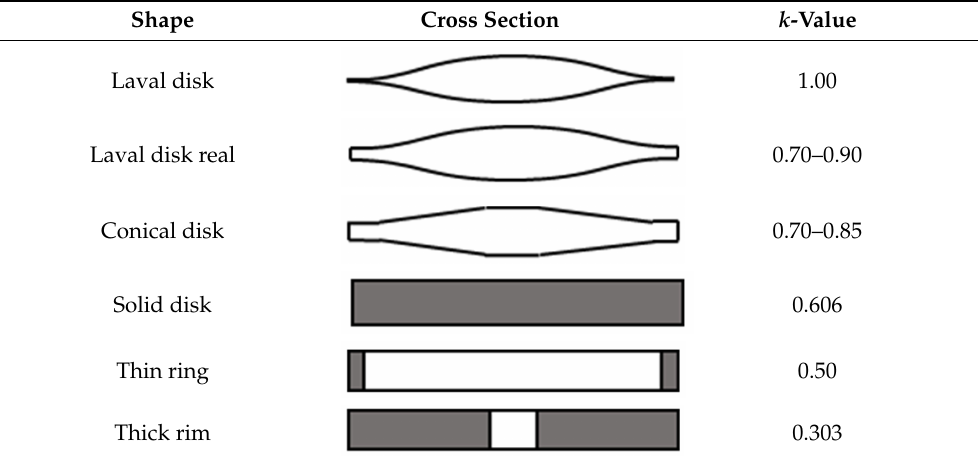
Table 2. Shape factor values ( k ) for various flywheel rotor cross sections.